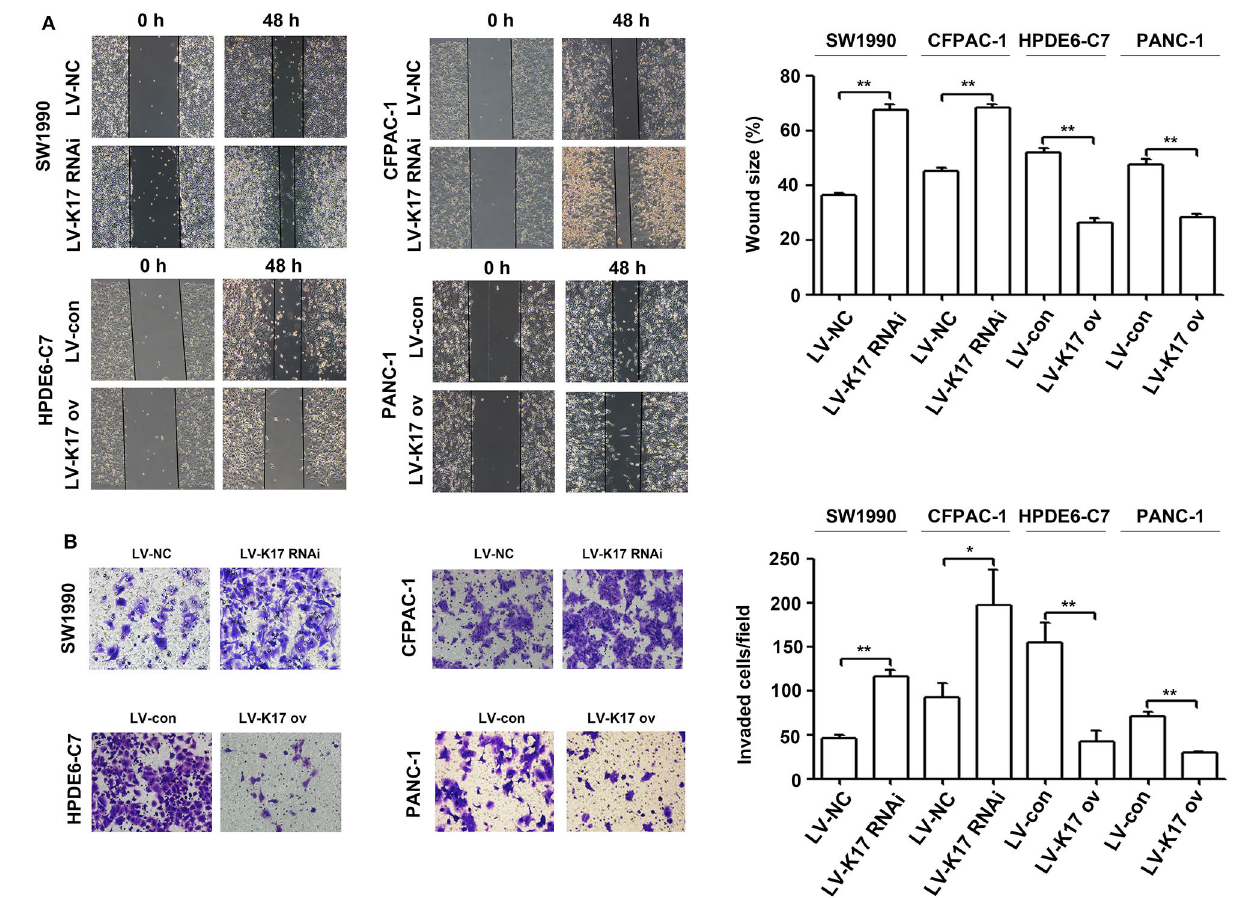
FIGURE 6 | K17 inhibited cell migration and invasion in pancreatic cancer cells in vitro . (A) A wound healing assay was used to determine the cell migration ability of stable K17-silenced SW1990 and CFPAC-1 cells and of stable K17 upregulated HPDE6-C7 and PANC-1 cells. (B) Cell invasion of stable K17-silenced SW1990 and CFPAC-1 cells and stable K17 upregulated HPDE6-C7 and PANC-1 cells was tested with a Transwell assay. * P < 0.05, and ** P <